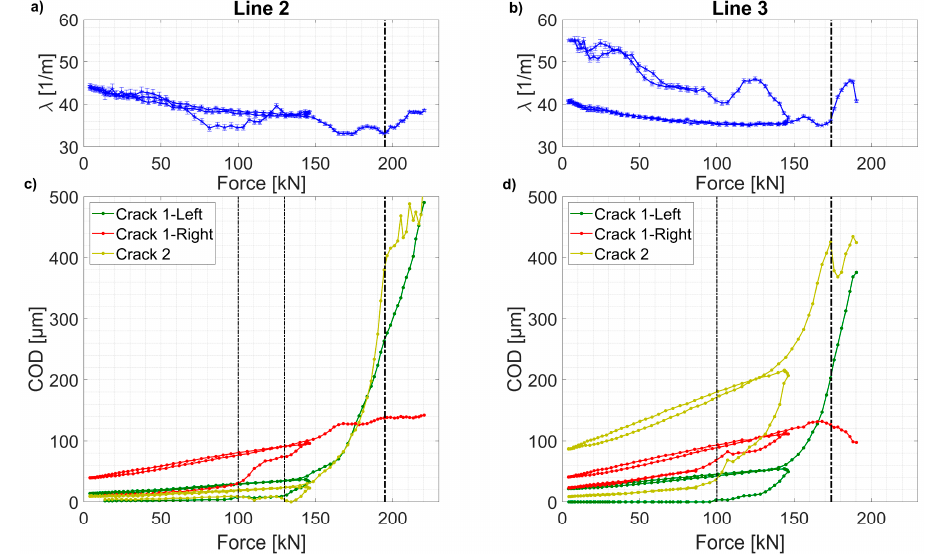
Figure 17. Variation of the estimated COD (( a , b )) and λ (( c , d )) during the test; fictitious crack initiation marked with thin dashed lines; loss of precision marked with thick dashed lines.